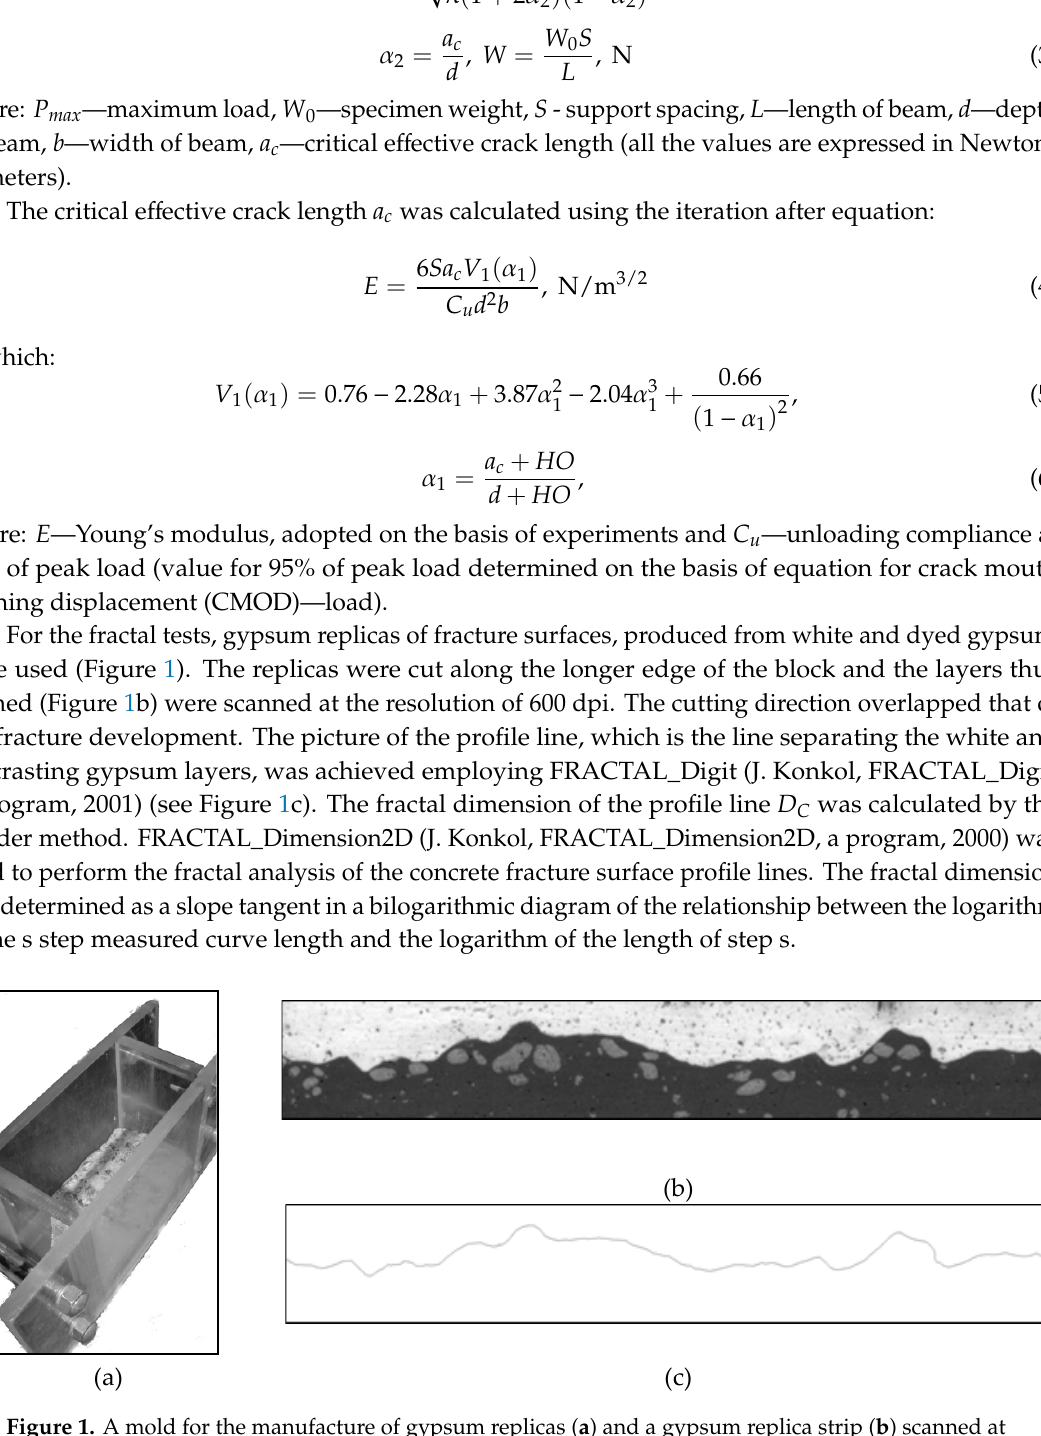
Figure 1. A mold for the manufacture of gypsum replicas ( a ) and a gypsum replica strip ( b ) scanned at definition resolution of 600 dpi, together with the digitization results ( c ).